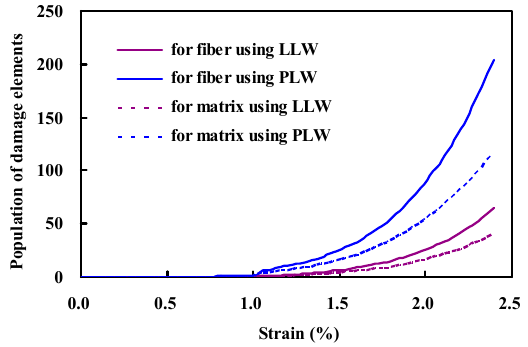
Figure 5. Damage evolution in the fiber and matrix during loading.